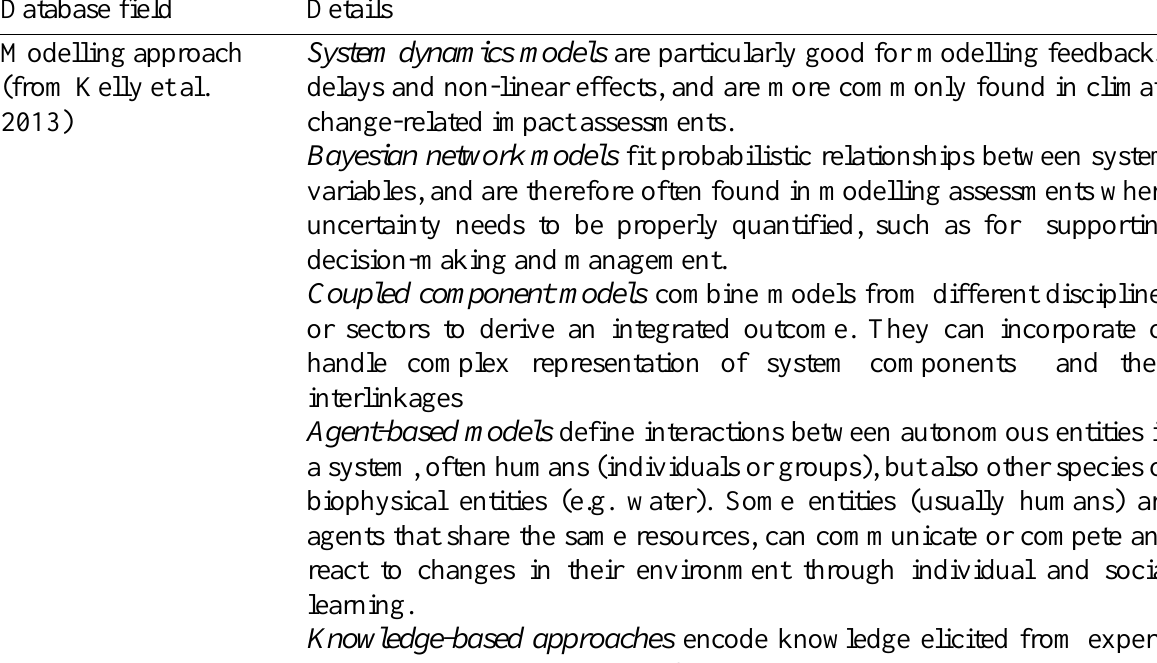
Table A3.2: Information extracted from the selected articles. The right-hand column lists in detail the different categories into which we classified each study within each information